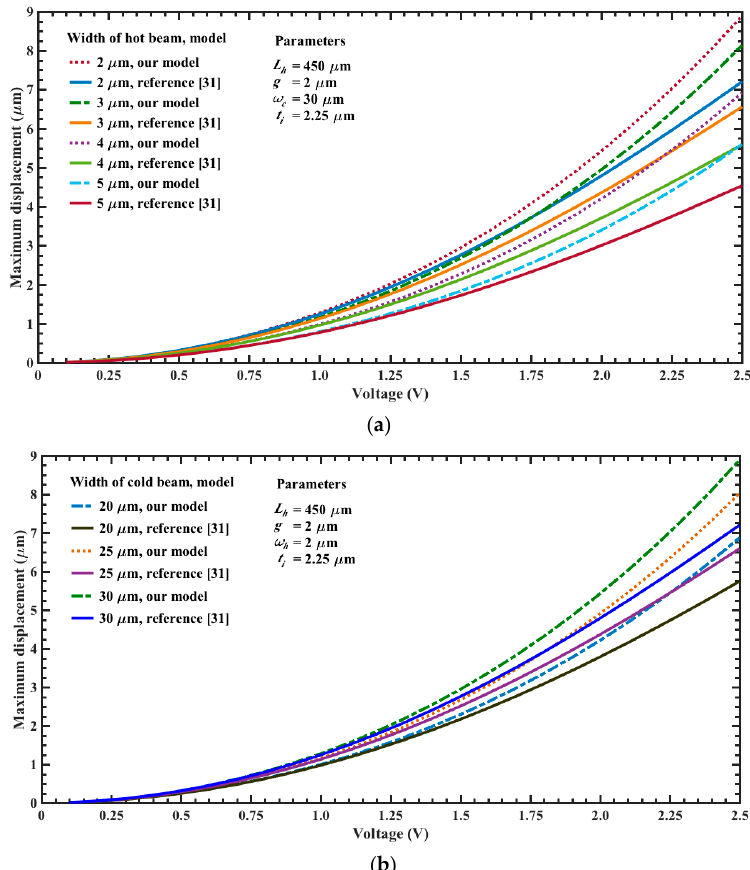
Figure 10. Maximum out-of-plane displacements of the electrothermal actuator tip as a function of bias voltage, regarding different lengths and two width values for the upper beams: ( a ) 2 μ m and ( b ) 5 μ m.